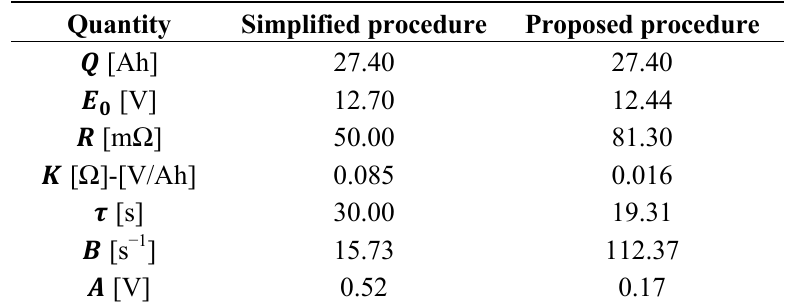
Table 2. Values of model parameters obtained from the two